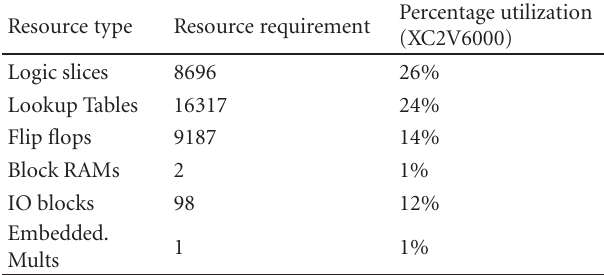
Table 3: Logic resources for MFCC module.